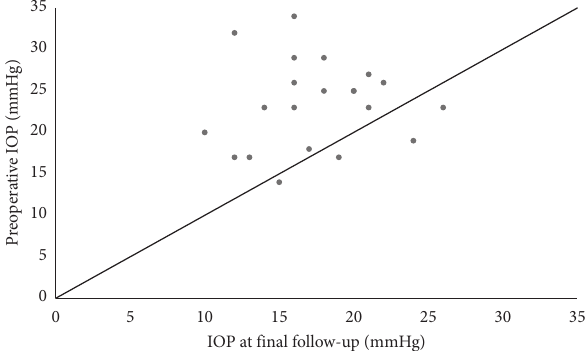
Figure 3: Scatter plot comparing preoperative intraocular pressure (IOP) with IOP at final follow-up. Each dotted symbol represents a single subject. Dots that are above the diagonal line represent subjects with lower IOP at final follow-up compared to their preoperative baseline